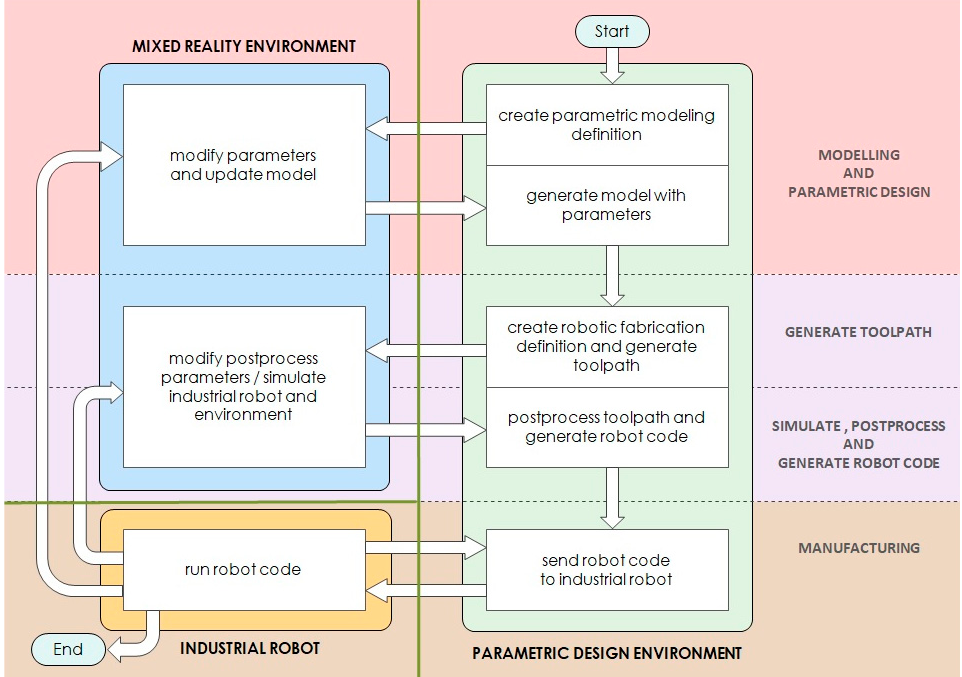
Figure 3. The role of the mixed-reality tool, the industrial robot, and the parametric-design software in the proposed workflow.